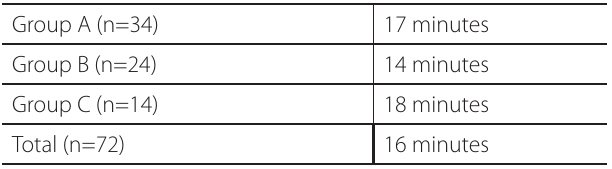
Table 5 . Mean aortic clamping time for coarctation of the aorta repair.